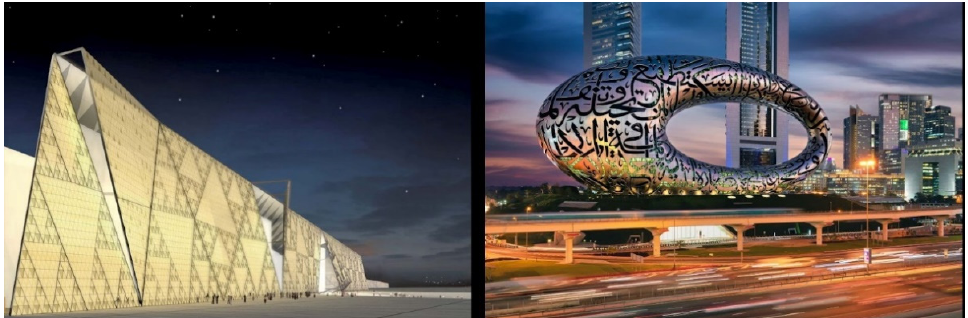
Figure 4. Samples of major museums designed with parametric approaches. On the ( left) , the Grand Egyptian Museum in Giza, designed by Heneghan Peng Architects (BIM model realized by DVA). On the ( right) , the new Museum of the Future in Dubai by Killa Design.